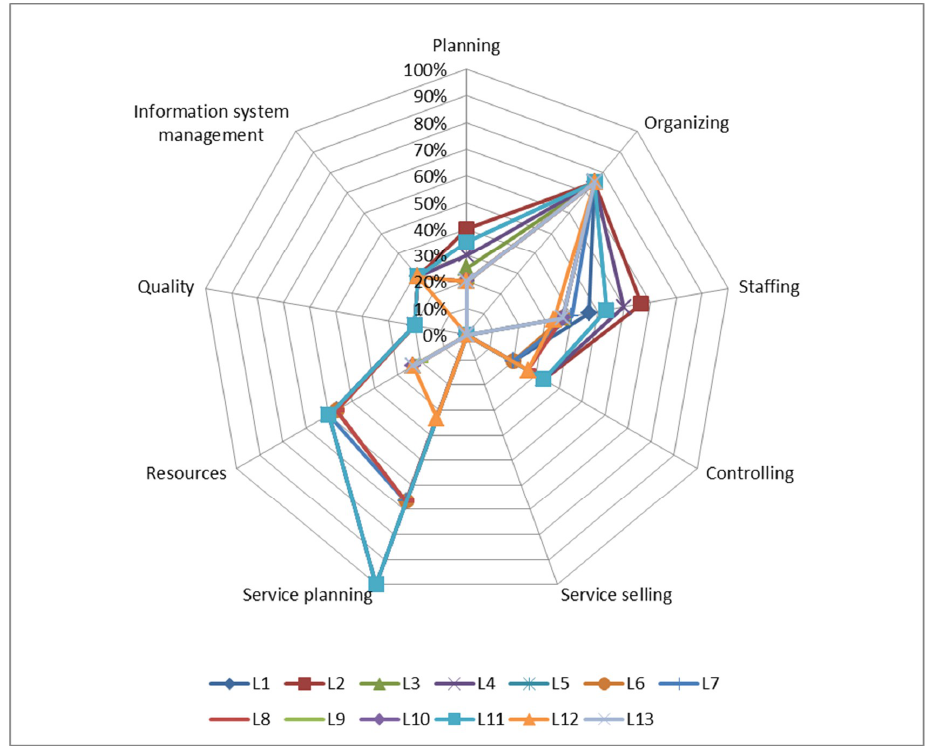
Figure 3. Radar chart of laboratories readiness mapping.